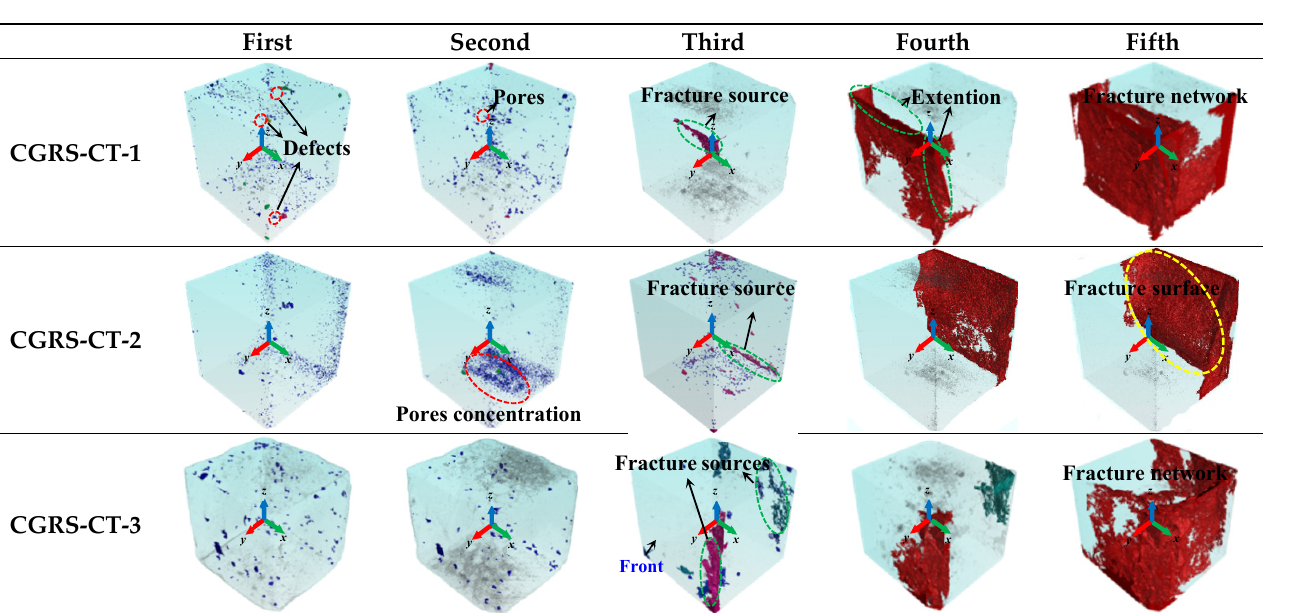
Figure 5. Schematic diagram of the cyclic loading and unloading process and CT scanning points.